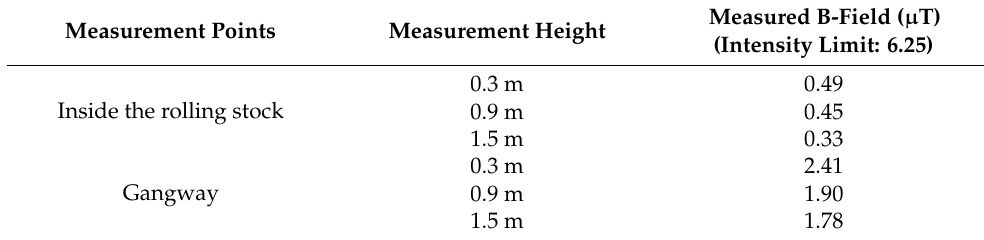
Table 3. Magnetic field measurements inside the rolling stock.